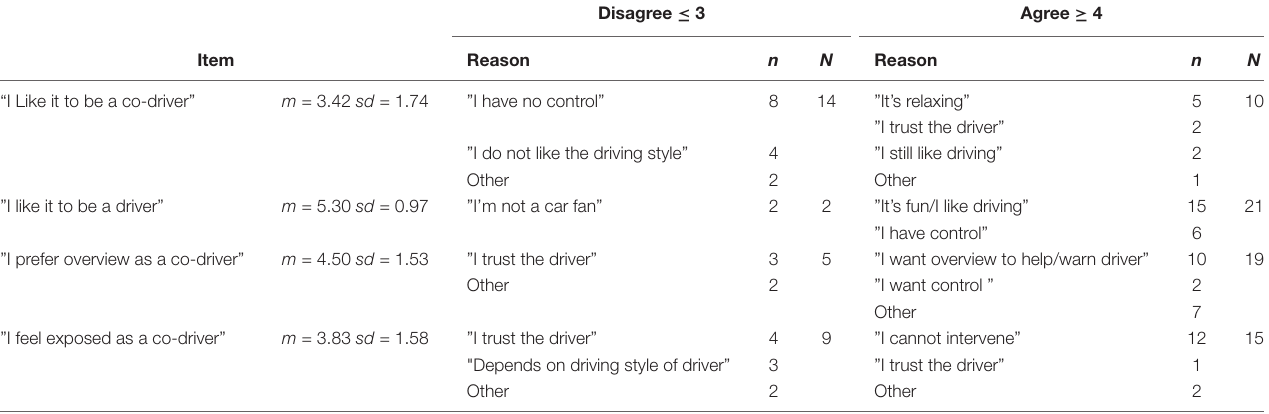
TABLE 2 | Distribution of ratings for personal characteristics (Item) and named reasons for ratings by